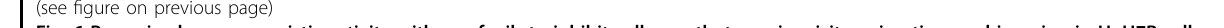
(Fig. 7c). Tumor proliferation (Ki-67) and apoptosis